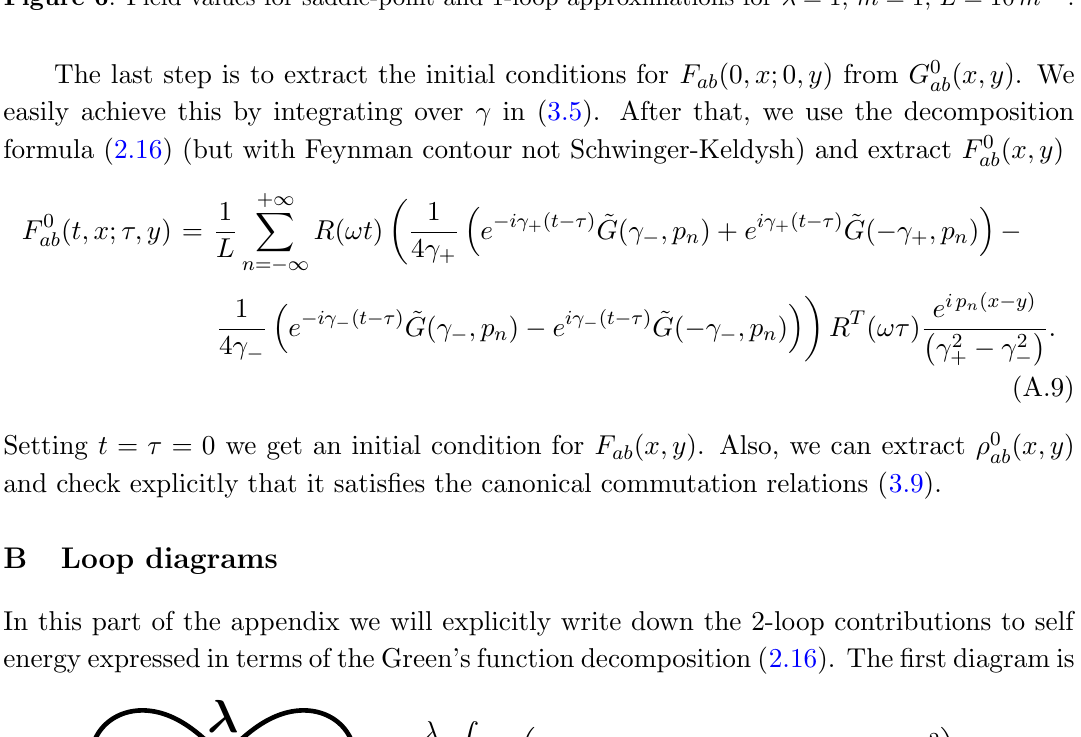
Figure 6 . Field values for saddle-point and 1-loop approximations for (cid:21) = 1, m = 1, L = 10 m (cid:0) 1